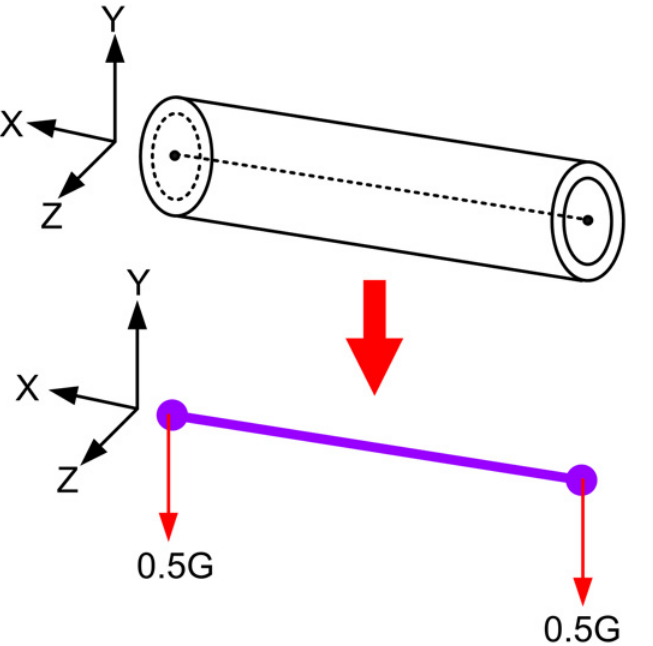
Fig 3. 3D beam element